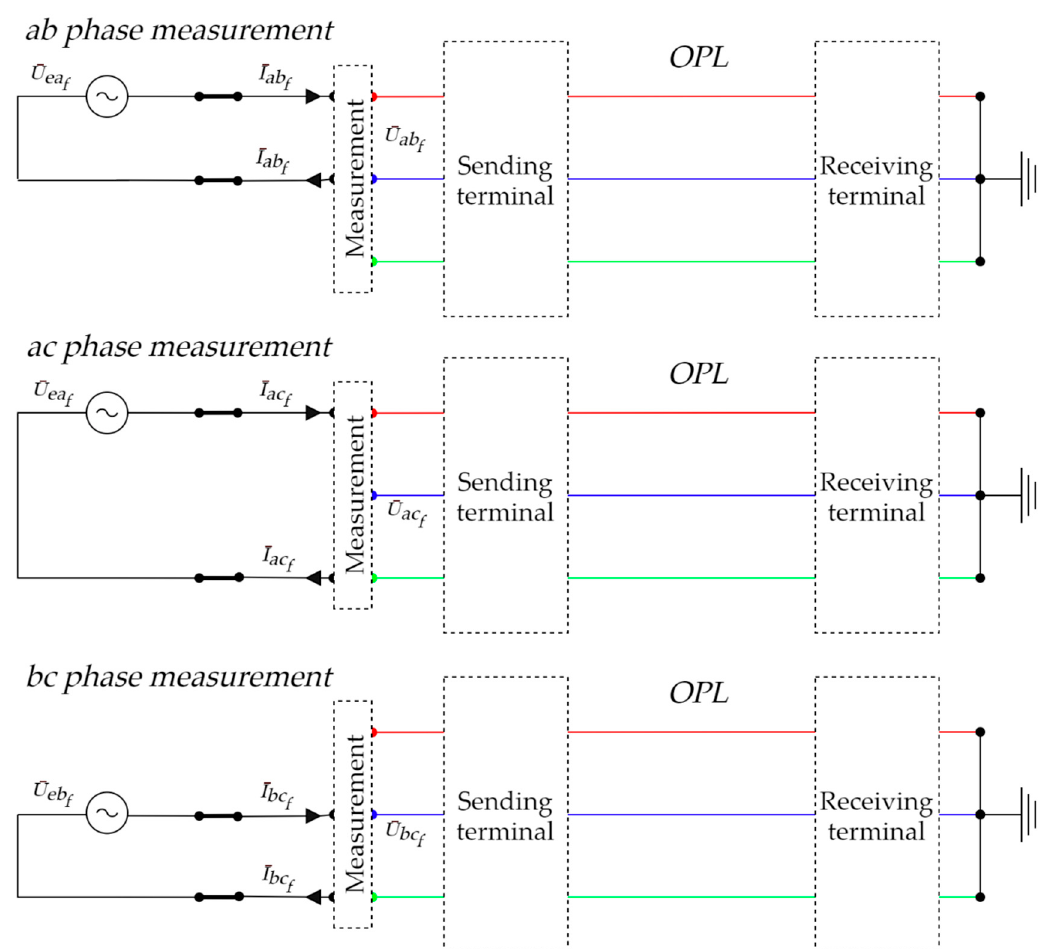
Figure 3. M2—Single-phase measurement of positive sequence impedance by phase-phase loops.